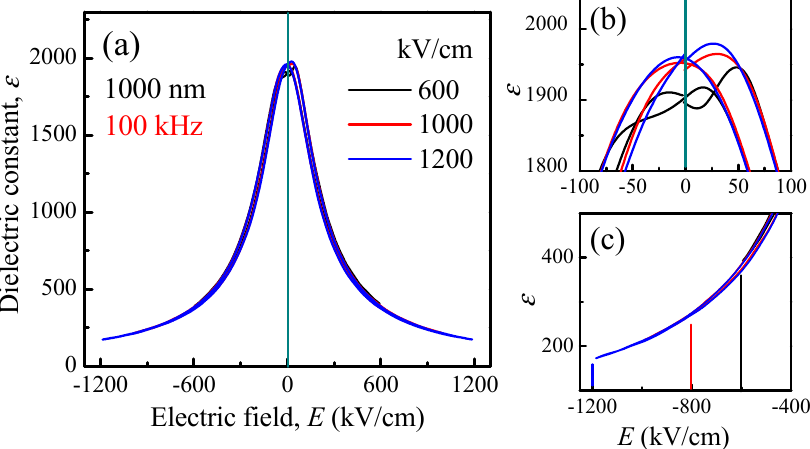
Figure 5. ( a ) Electric field dependent ε - E curves of 1000-nm PLZT films measure at 100 kHz. Zoom-in in ( b ) near the peaks and ( c ) in the high-field regions of ε - E curves. Equation (8) shows that the ε r ,0 V value of a dielectric material is independent of